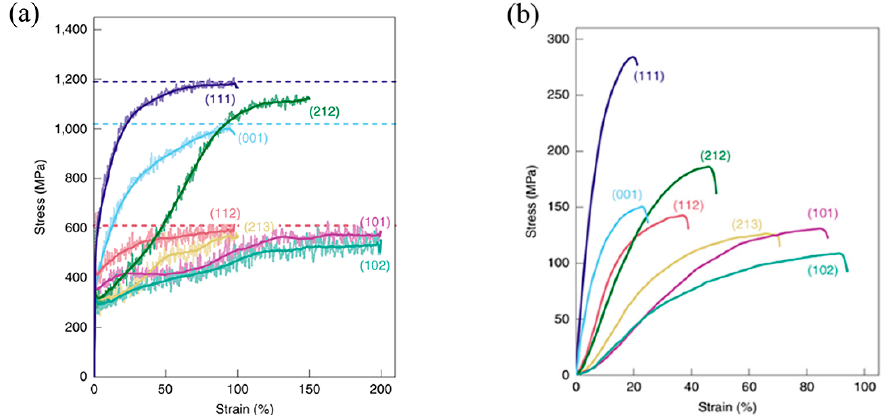
Figure 1. The stress–strain curves of single crystal nickel with an initial orientation of [001] (black line) and [111] (gray line), as obtained by the MD simulations [37].